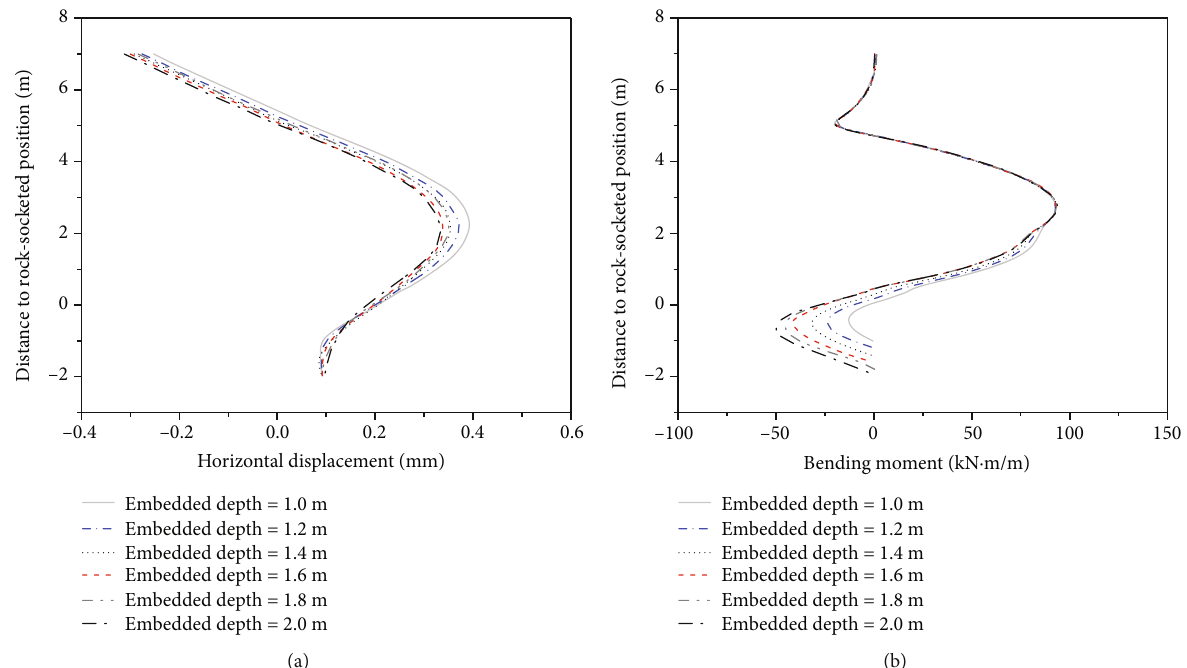
Figure 21: E ff ects of embedded depth on the horizontal displacement and bending moment of the end-suspended pile. (a) Horizontal displacement. (b) Bending moment.